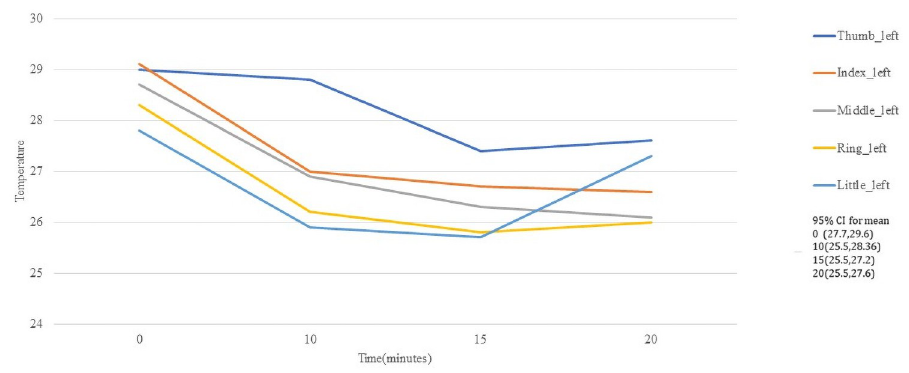
Fig 6. Temperature behaviour of the fingers in dorsal left hand.